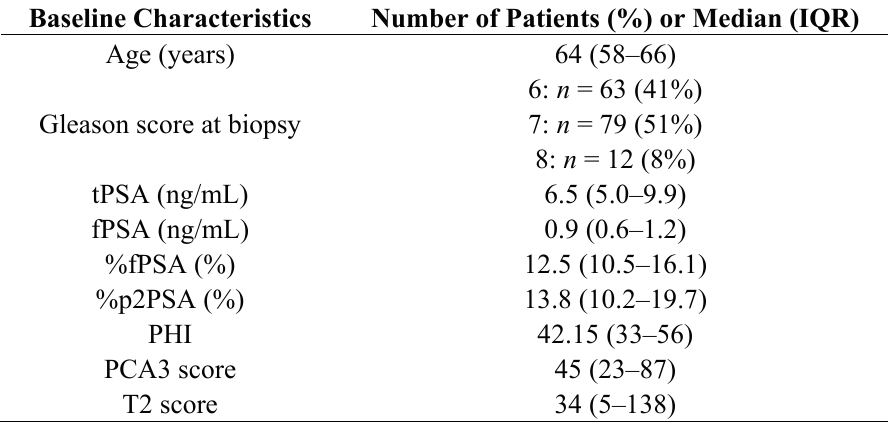
Table 1. Baseline characteristics of the 154 patients who underwent radical prostatectomy.